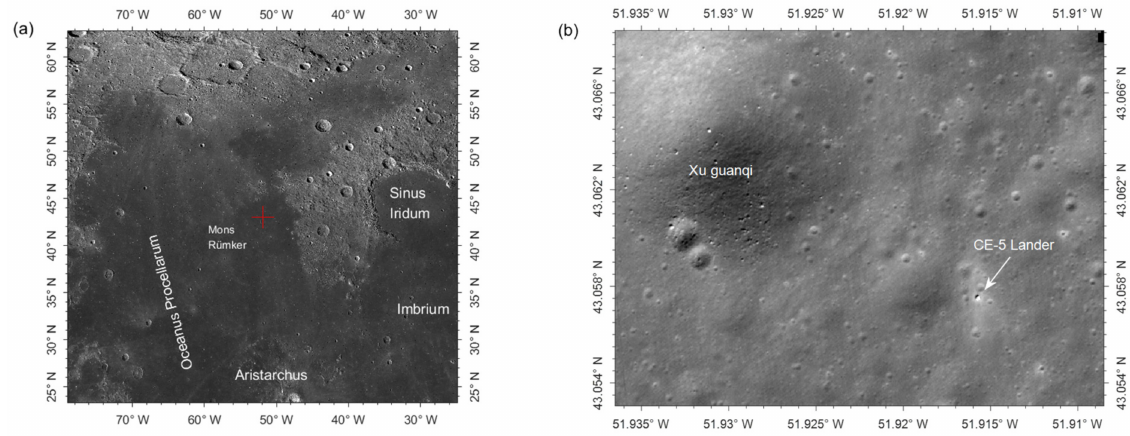
Figure 1. ( a ) Location of the CE-5 landing site (marked by a red cross). The base map is the Lunar Reconnaissance Orbiter (LRO) Wide-Angle Camera (WAC) image mosaic. ( b ) The CE-5 lander captured by LRO Narrow-Angle Cameras (NAC) on 2 December 2020 (NAC image ID: